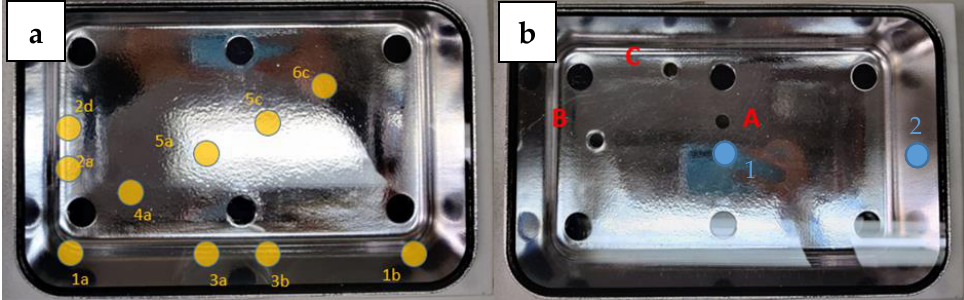
Figure 3. On the left ( a ), a representation of 10 points (in yellow) where the cosine corrector was inserted to measure irradiance. On the right ( b ), 3 holes (in red) drilled into the bottom of the box, and the two positions (in blue) selected to perform the tests.